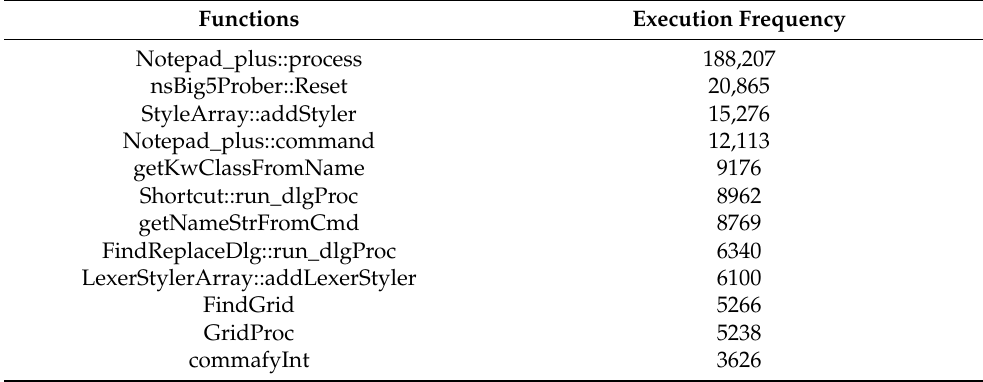
Table 4. Part of the execution frequency of 378 functions measured by running every menu once.